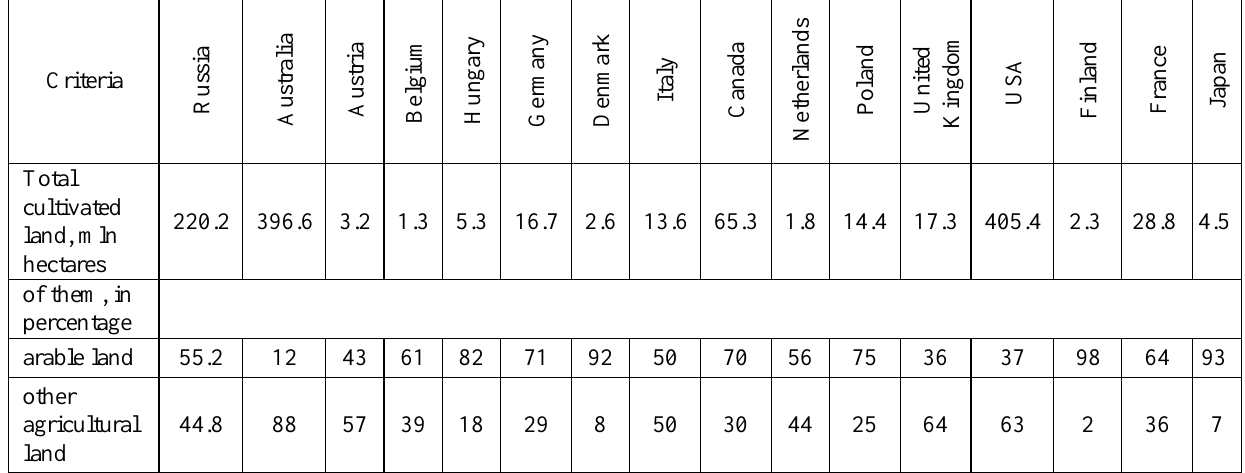
Table 2. The structure of cultivated land in 2013 in Russia and in some parts of the world [11]